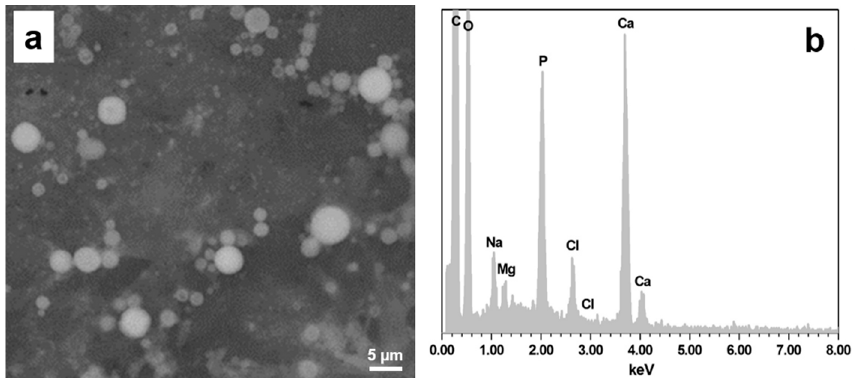
Figure 5. Rounded formations observed in the digested tissues. ( a ) Typical rounded crystallizations observed both in healthy and neoplastic digested tissues. ( b ) Typical EDS spectrum recorded on the crystallizations in ( a ), proving a calcium phosphate composition with small amounts of Mg substituting for calcium. Na and Cl peaks are ascribed to NaCl crystallization during the digestion process.